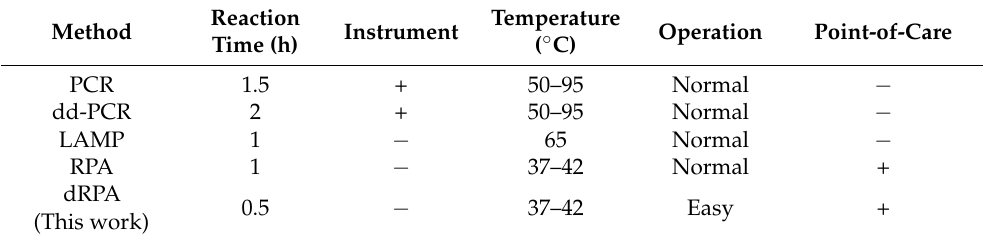
Table 6. The comparison of dRPA and other detection